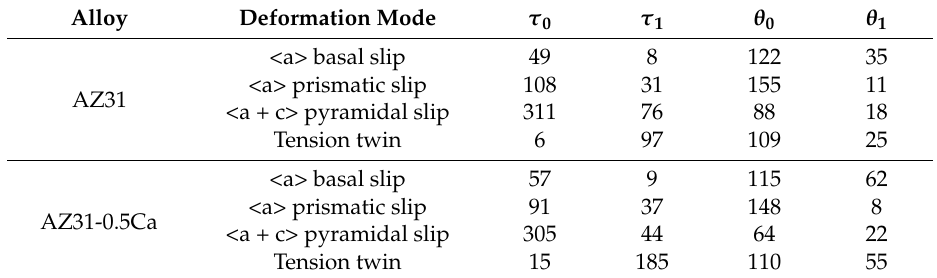
Figure 9. Experimentally observed and VPSC-modeled (0001) pole figures and tensile curves of the 10%-tensile-deformed AZ31 and AZ31-0.5Ca alloy samples. For tensile curves, the samples of the two alloys were deformed along the RD. Table 4. CRSS values and hardening parameters of the AZ31 and AZ31-0.5Ca alloys as modeled by the VPSC. All values listed in this table were obtained for tensile tests along the RD of the samples.